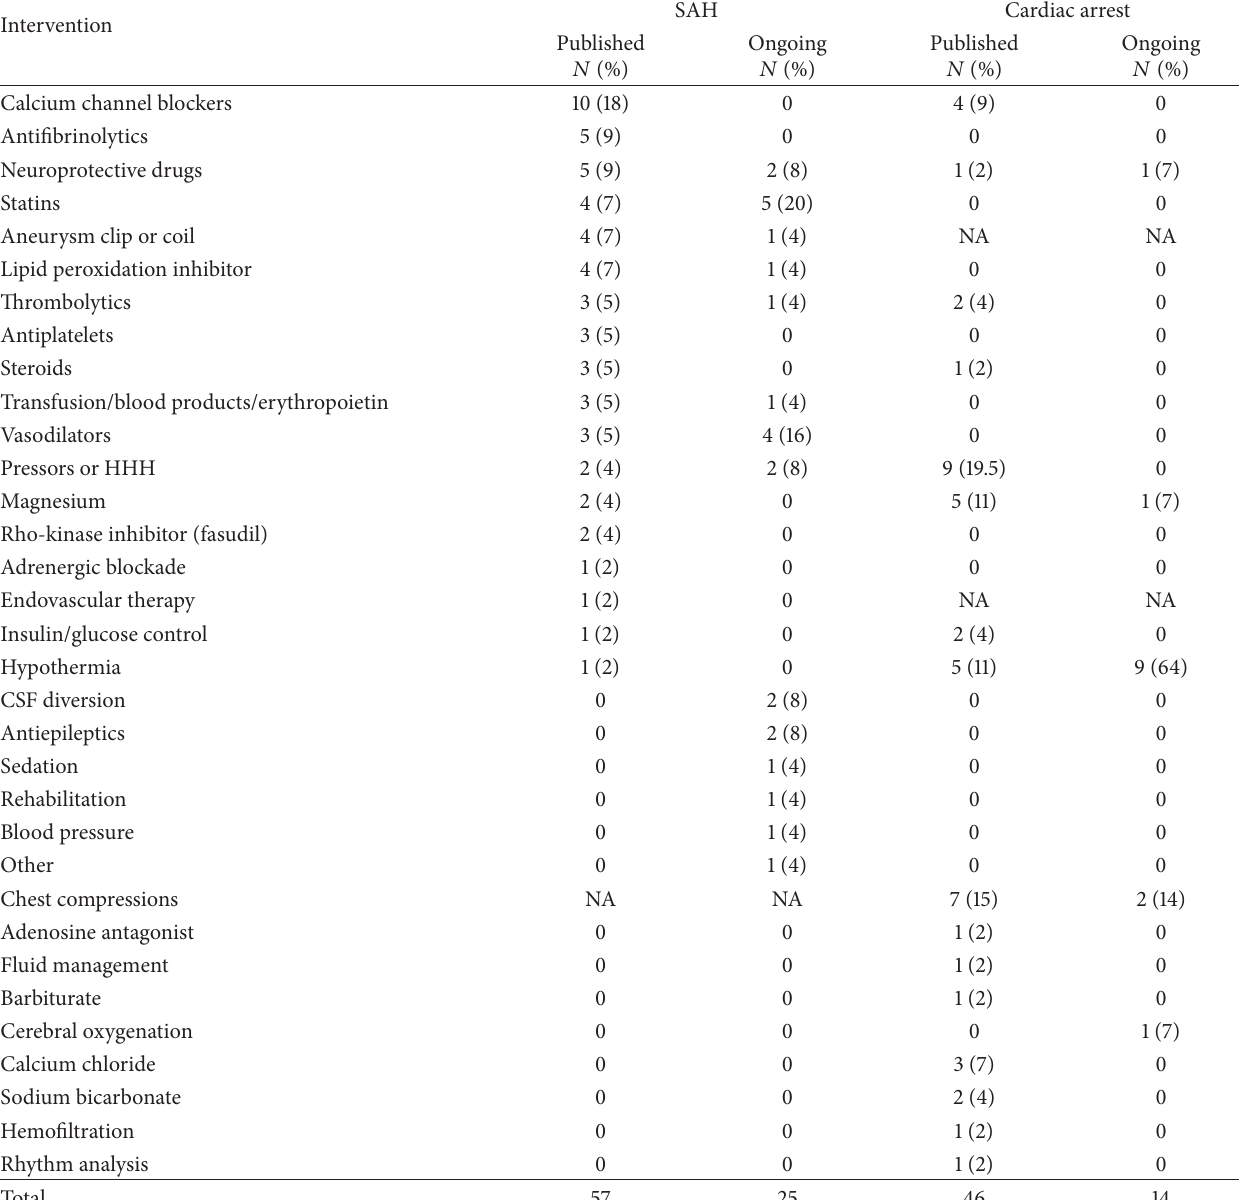
Table 5: Number of randomized, controlled trials published and ongoing for aneurysmal subarachnoid hemorrhage and cardiac arrest. Intervention